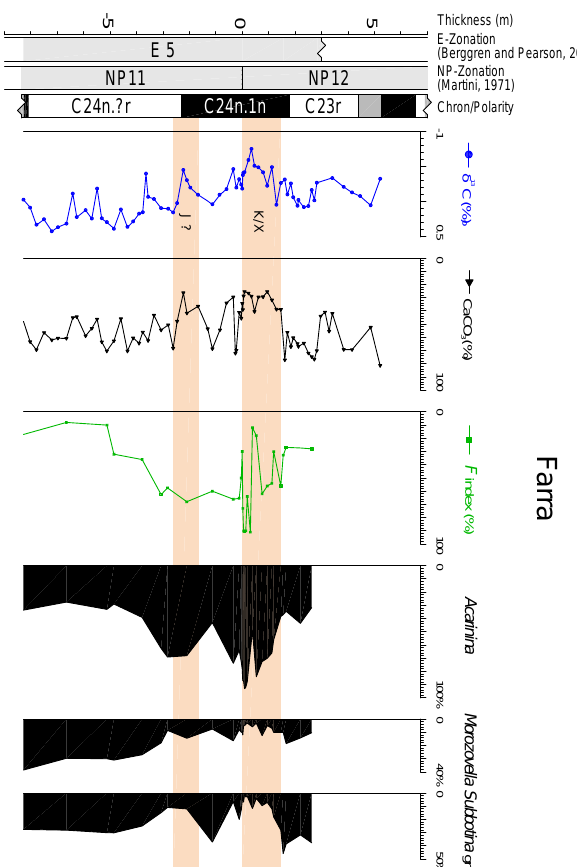
Figure 10. Records of magnetostratigraphy, bulk sediment δ 13 C, CaCO 3 content, F -index and abundance patterns for primary plank- tic foraminiferal taxa at the Farra section, which crops out 50km NE of Possagno. All data are from Agnini et al. (2009). Note that the switch in abundance between Morozovella and Acarinina occurs close to the J